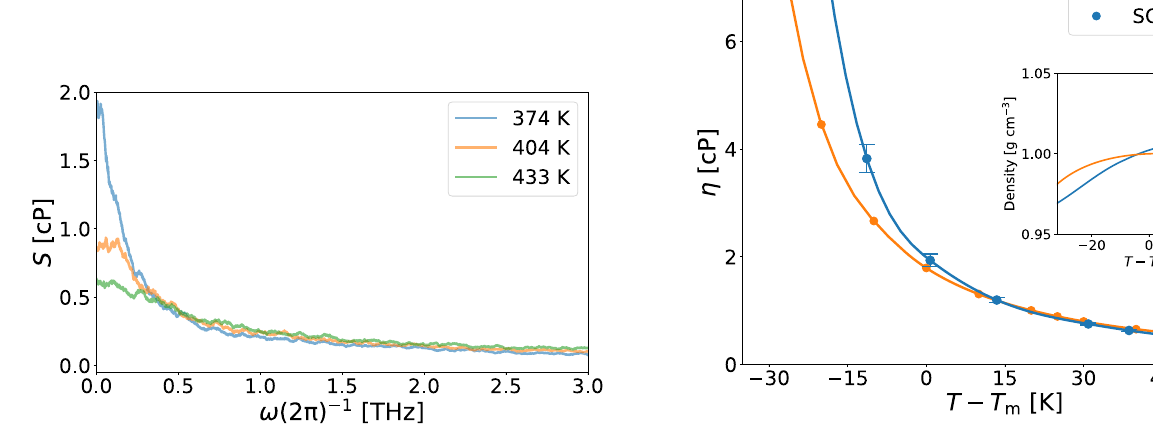
Fig. 9 Comparison between the SCAN predictions and the experimental values for the shear viscosity of water as a function of the temperature. The temperature scale for SCAN data has been offset by the difference between the theoretical and experimental melting temperatures, T m (see text). Error bars represent standard deviations.